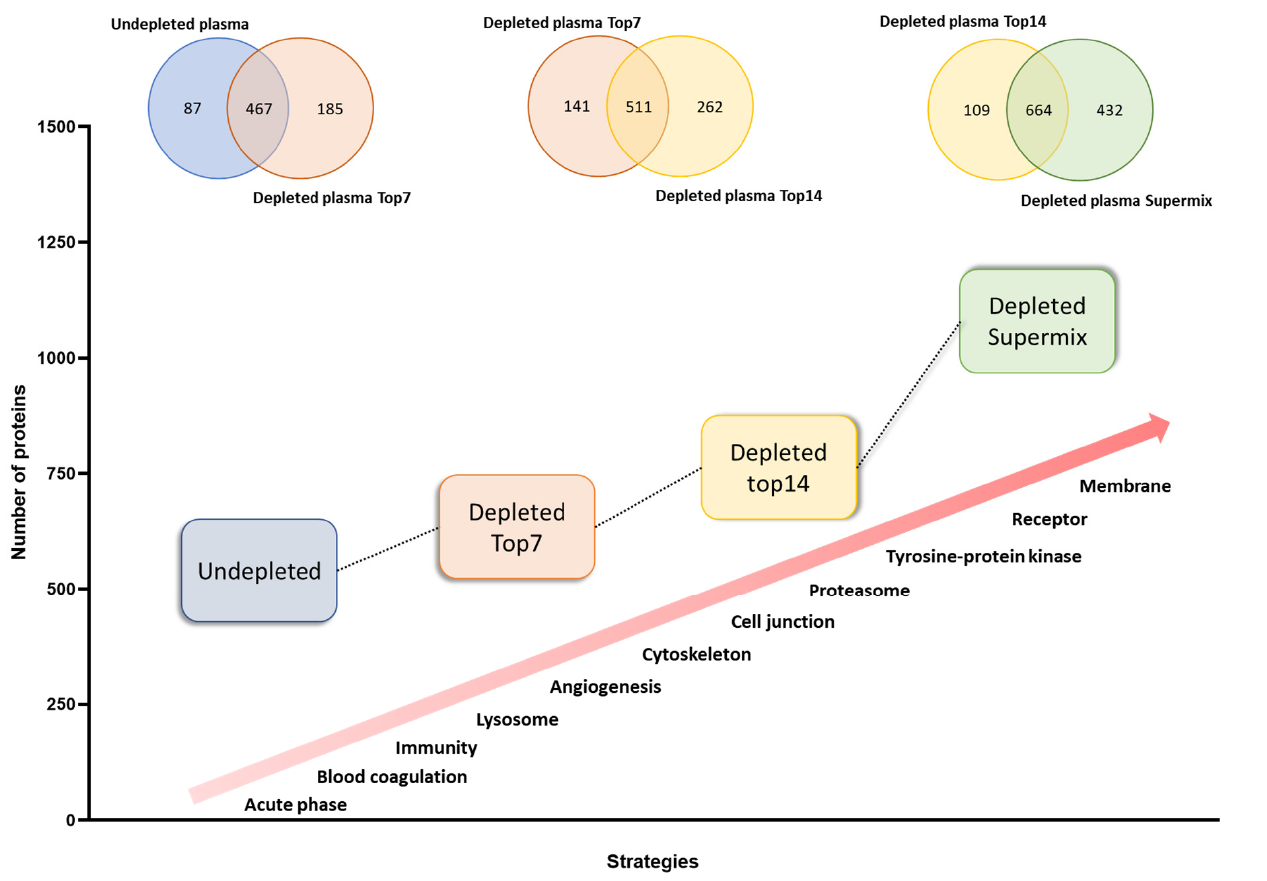
Figure 2. Qualitative evaluation of whole and immunodepleted plasma proteomes. Characterization of the 4 strategies used in this work according to the number of proteins identified and the specifically enriched protein classes or biological process.